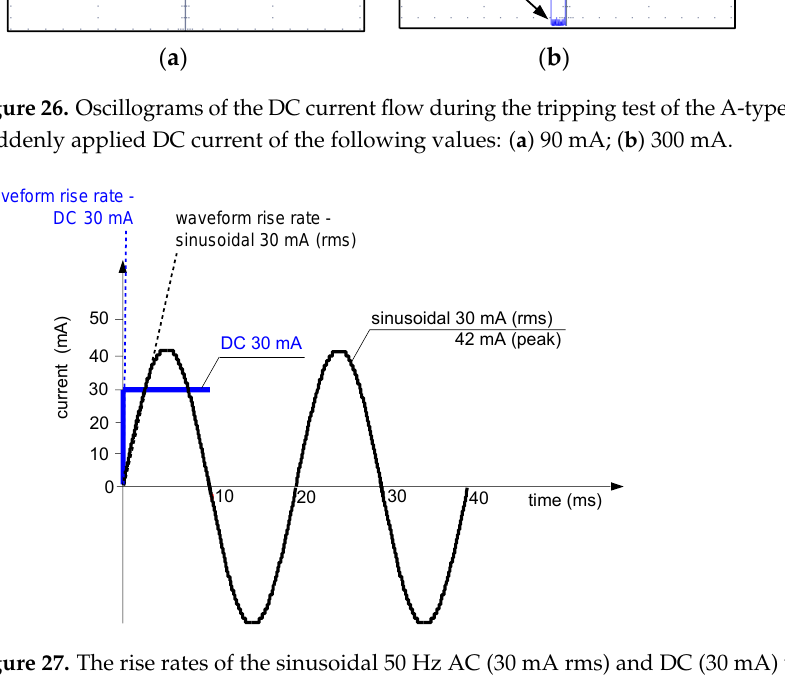
Figure 27. The rise rates of the sinusoidal 50 Hz AC (30 mA rms) and DC (30 mA) waveforms.